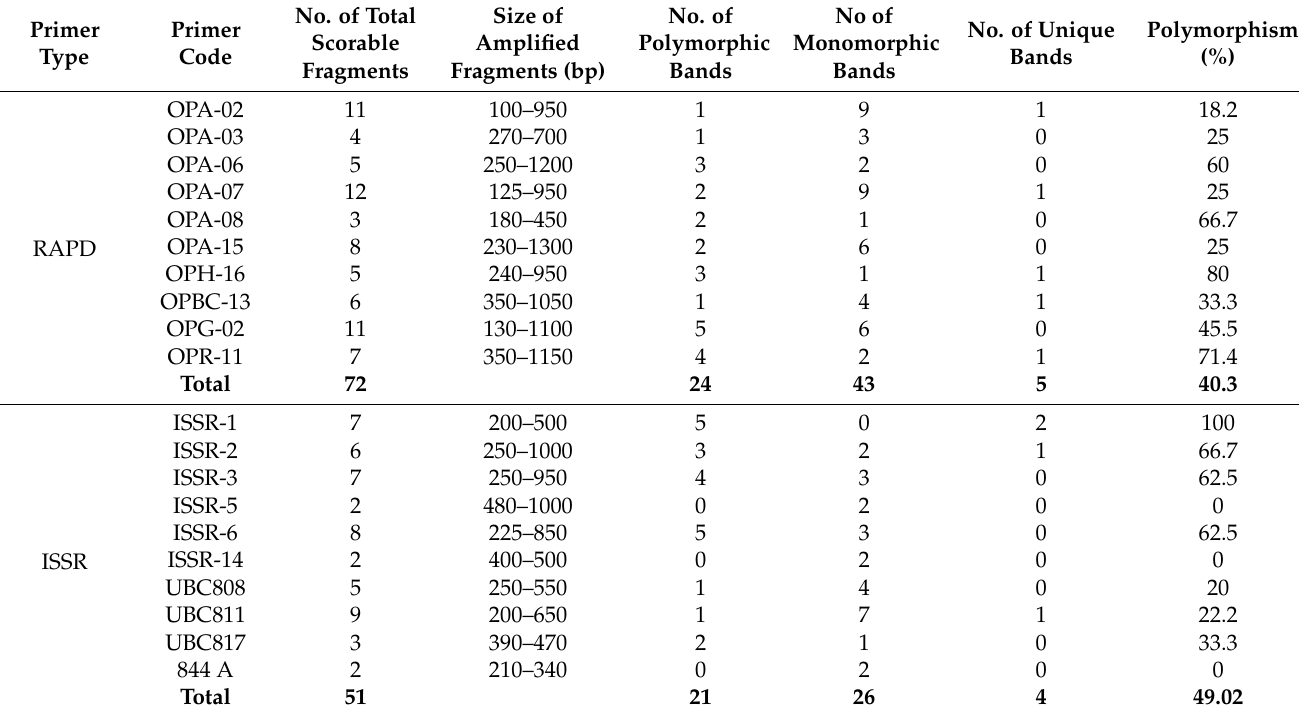
Table 10. RAPD and ISSR analysis to determine somaclonal variation among different paulownia lines as influenced by long-term culture on MS medium containing 2 mg/L BAP and 0.1 mg/L NAA for one